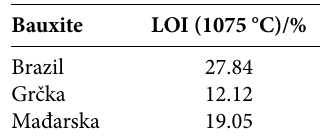
Table 6. The content of TiO 2 in one bead of the bauxite sample “Grčka” calculated using the XRF method (by fusion) Number